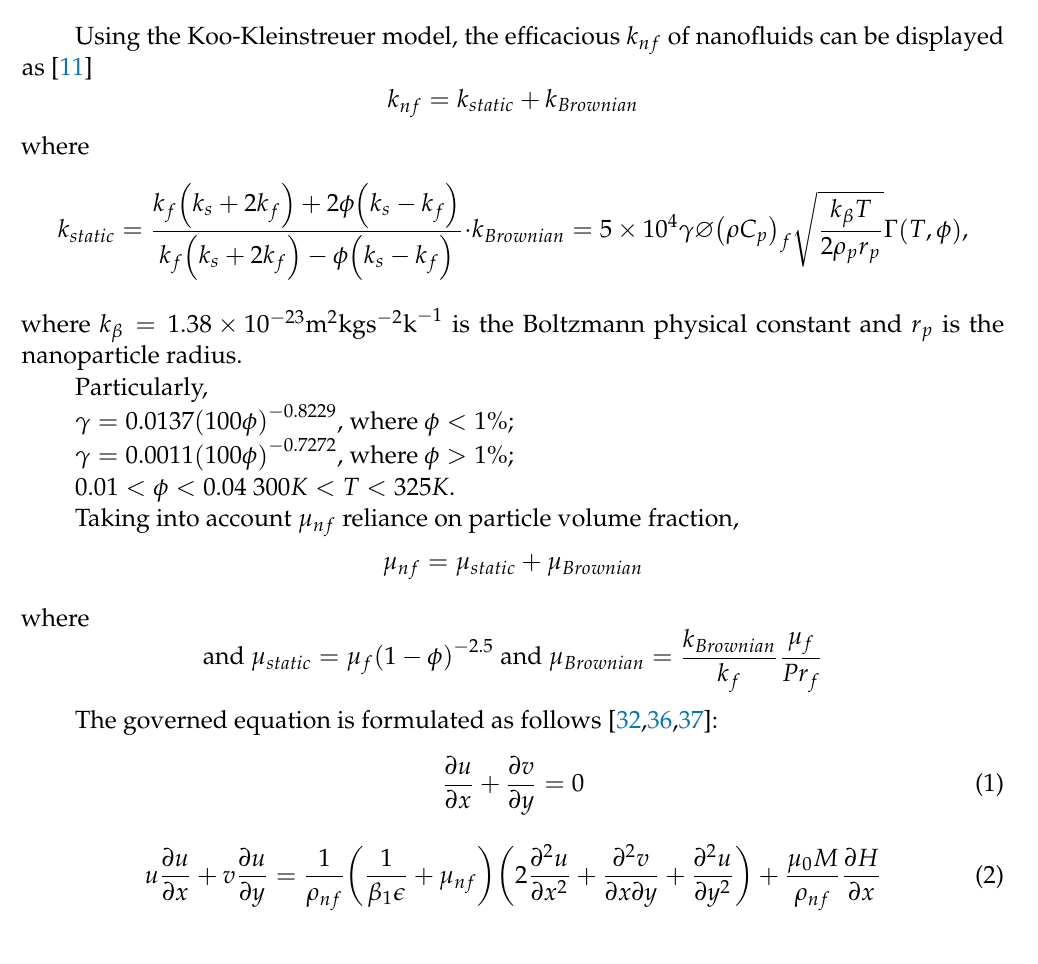
Figure 1. Physical description flow